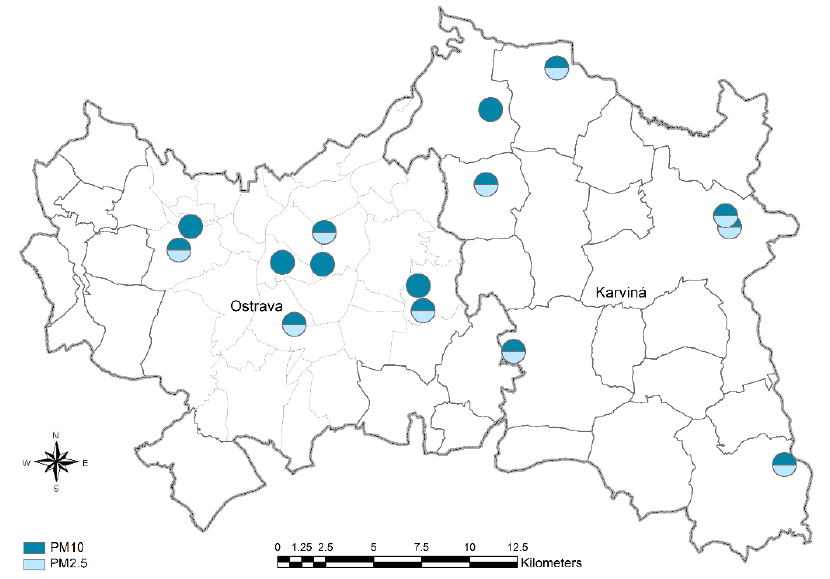
Figure 1. The distribution of the ISKO measurement stations across the study areas. The PM 2.5 concentrations are presented as means, and the cadastral units and resi- across the geographical units are presented graphically on the maps.